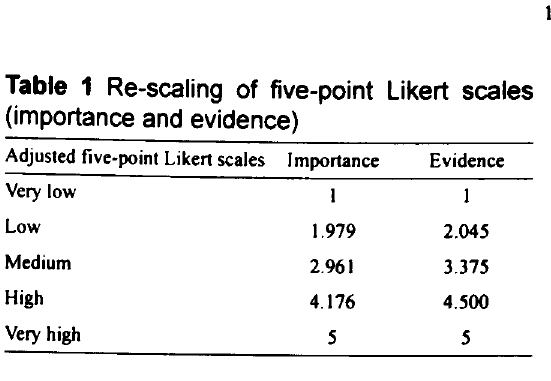
Table 1 Re-scaling of five-point Likert